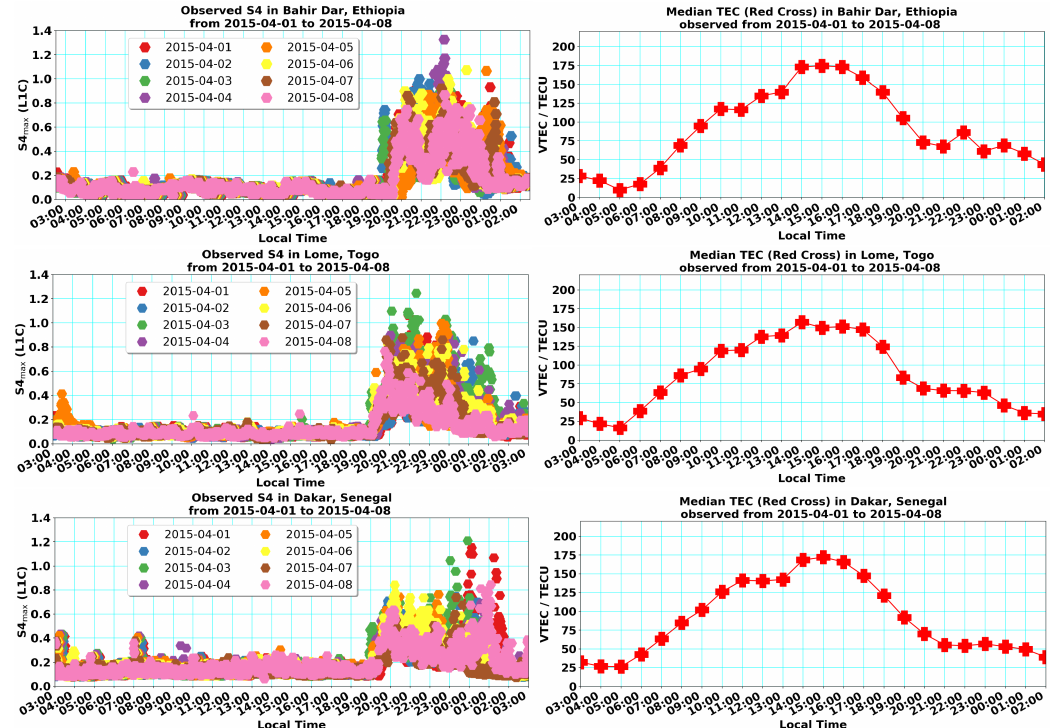
Figure 1. The local time behaviour of S 4 indices and mean TEC observed in Bahir Dar, Ethiopia (11.6 ◦ N, 37.4 ◦ E), Lomé, Togo (6.2 ◦ S, 1.2 ◦ E) and Dakar, Senegal (14.2 ◦ N, 17.5 ◦ W) during the period 1–8 April